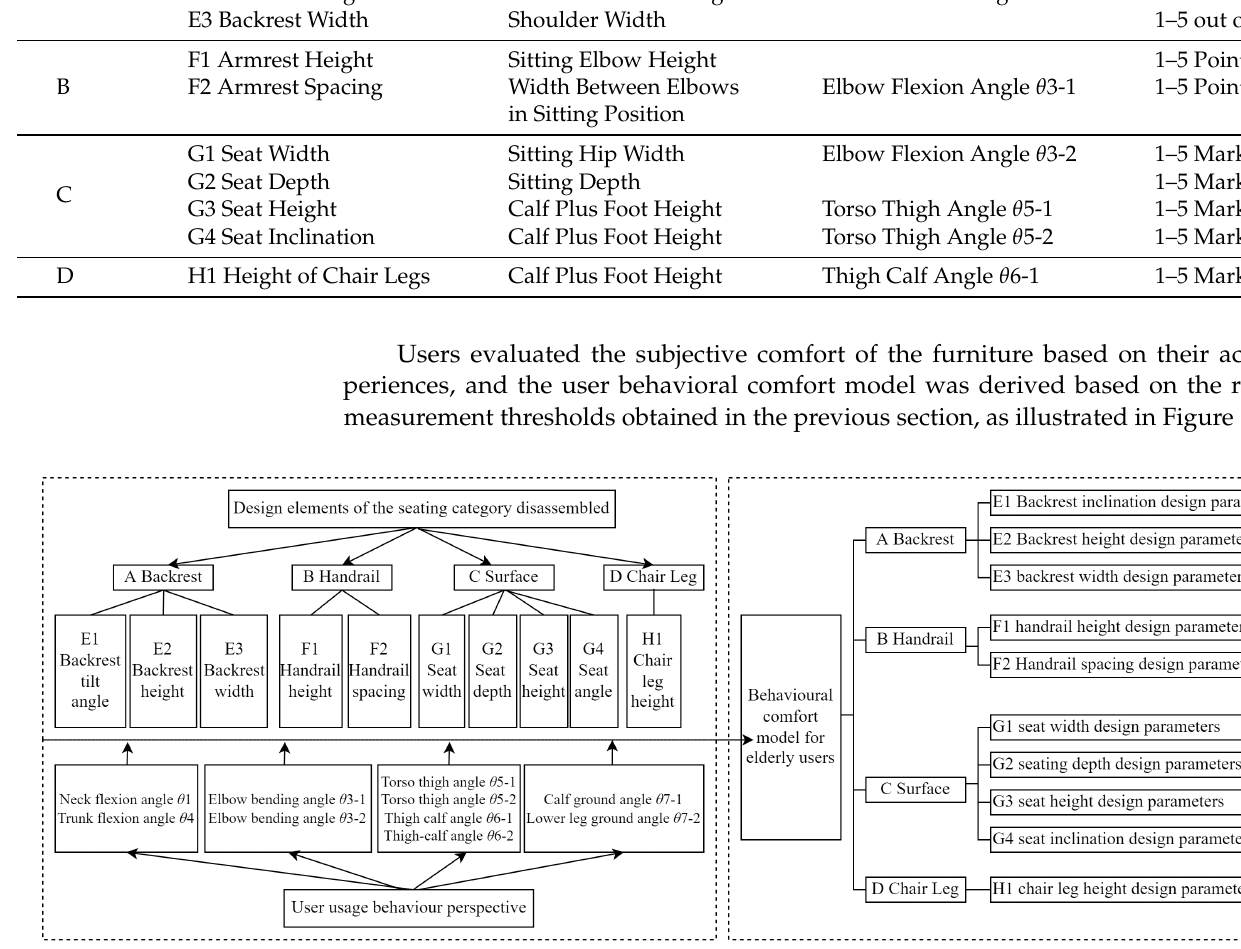
Figure 12. Behavior comfort model of elderly